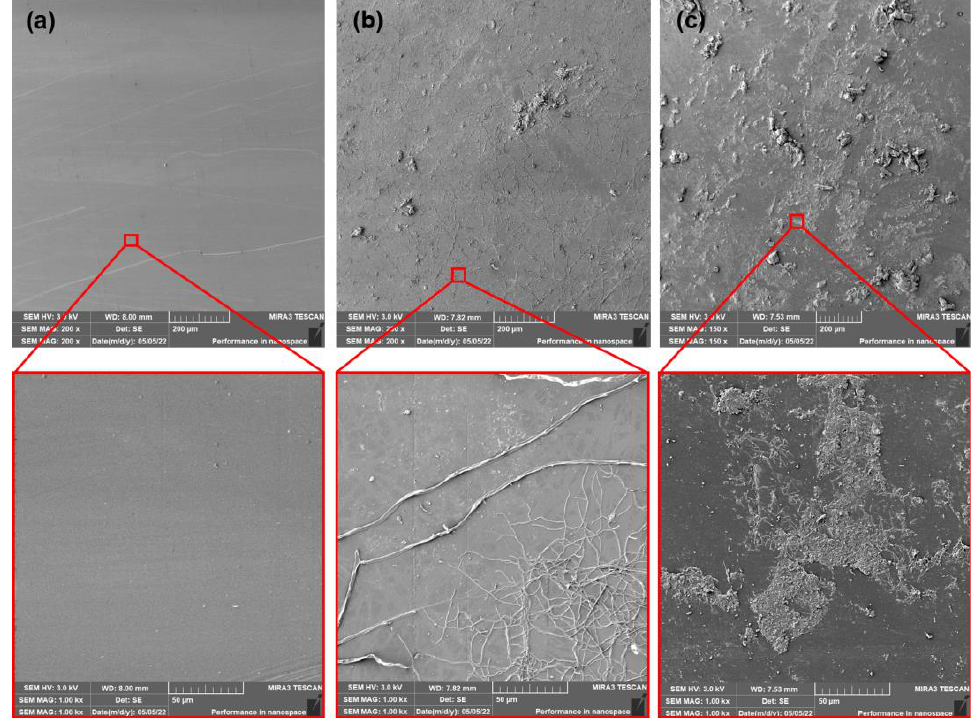
Figure 12. SEM images of as-produced PLA/MC 2178 films ( a ) at initial state and after ( b ) 14 days of thermophilic composting, and ( c ) 28 days of thermophilic composting.